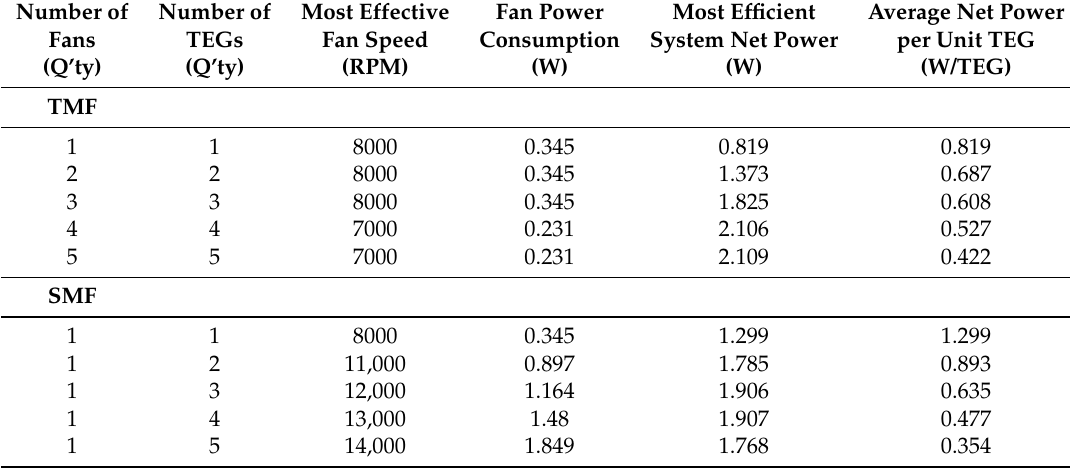
Table 3. Summary table of the most effective fan speed, the average net power per unit TEG, and the most efficient system net power according to the different TEG